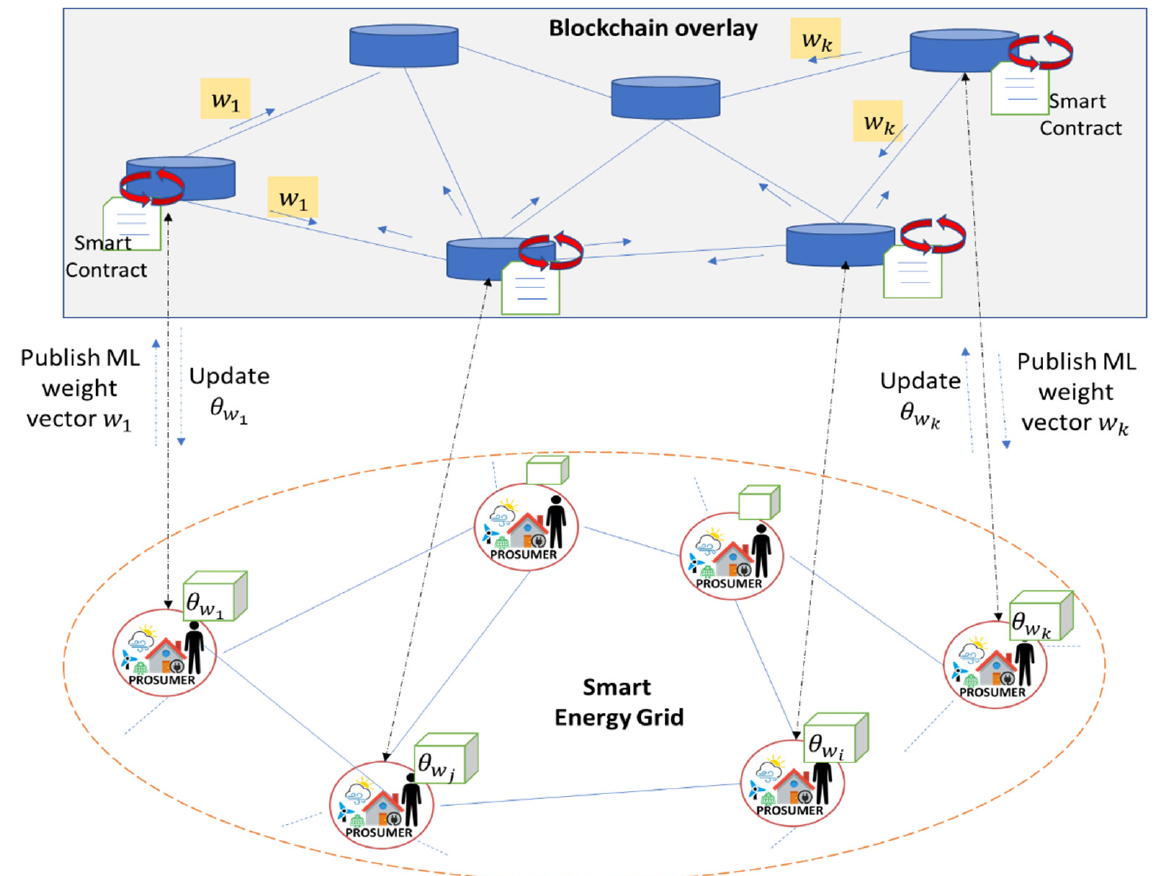
Figure 4. Blockchain-based distributed FL for prosumers energy prediction.